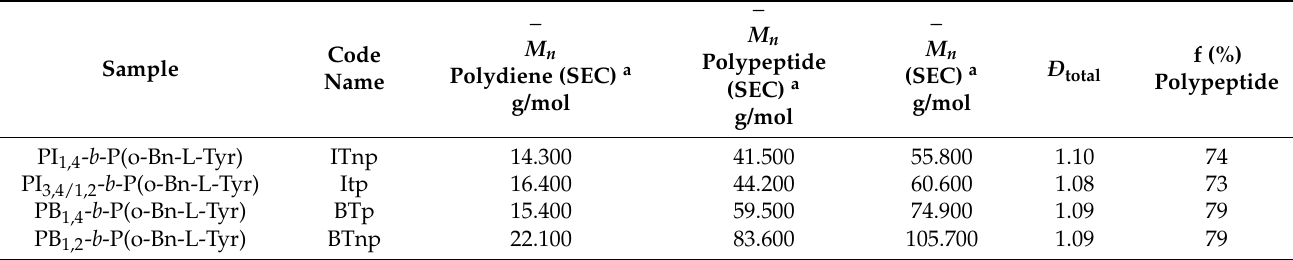
Table 1. Total number average molecular weight and dispersity indices for polydiene and poly(o-Bn-L-tyr) segments corresponding to all samples as directly calculated from